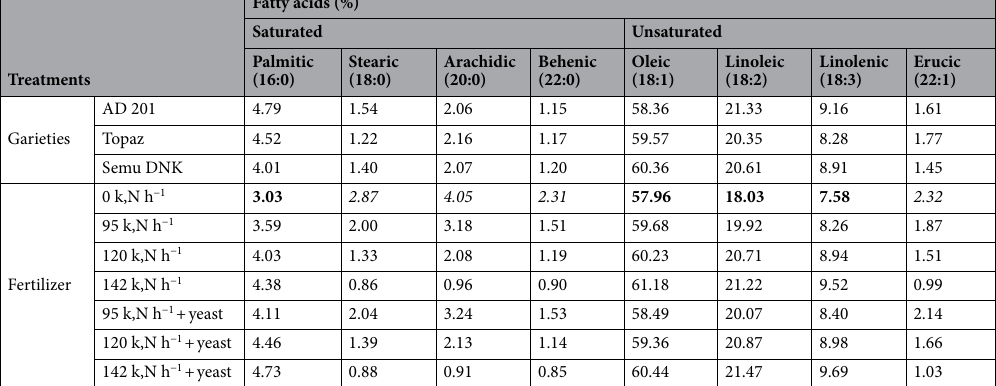
Table 5. Saturated and unsaturated fatty acids (%) in seeds of the three Canola genotypes and different N applications without and with yeast extract. Significant values are given in bold and italics.